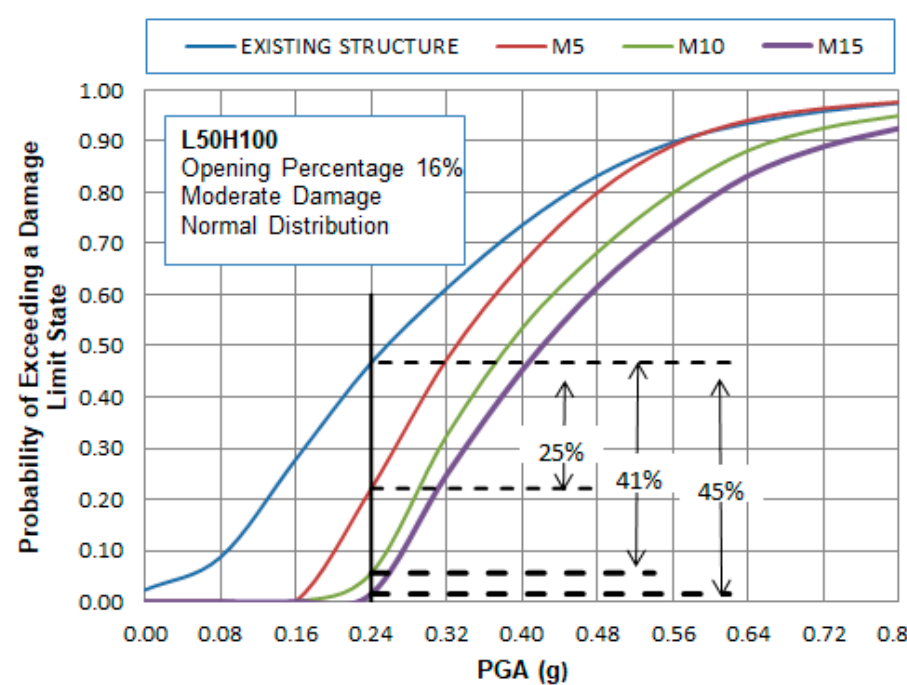
Figure 45. Fragility curves of wall L50H100, considering the Syrmakezis et al. (1995) failure criterion [8,25], for its current condition, as well as its behavior with the use of three different repair mortars of 5, 10 and 15 MPa compressive strength (M5, M10, M15), for lognormal distribution and moderate damage performance level.